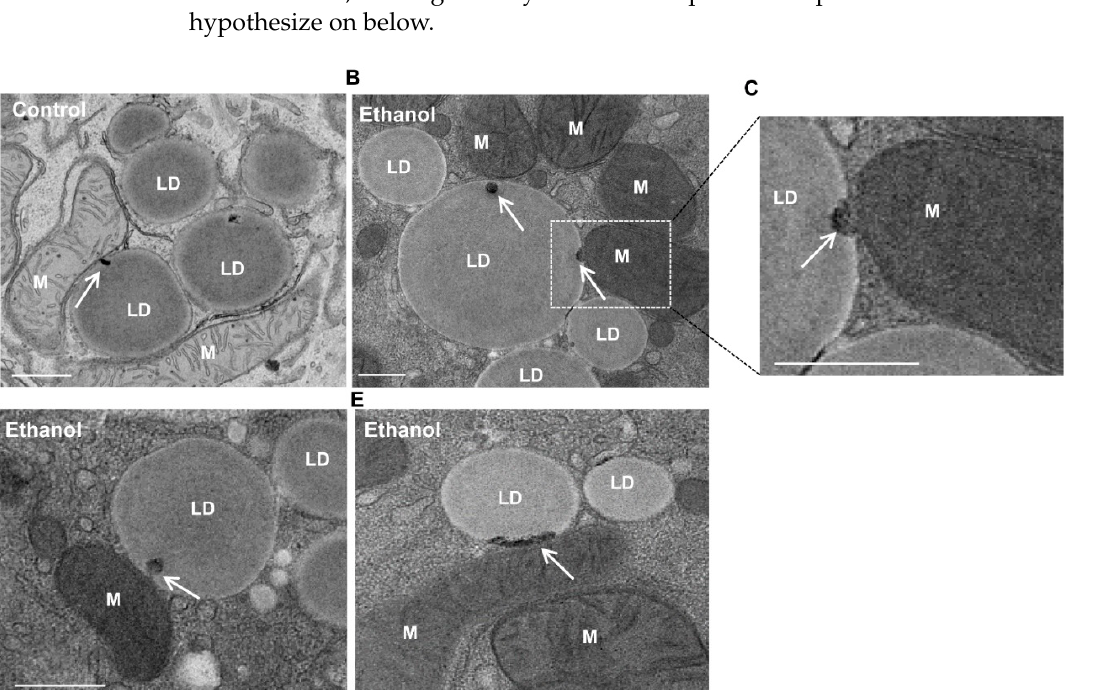
Figure 5. Dot- or tubular-like mitochondria–LD contact sites in starved or oleic-acid-treated primary mouse hepatocytes. Primary mouse hepatocytes were cultured in EBSS for 2 h followed by EM analysis. ( A ) Representative EM images from hepatocytes cultured in EBSS are shown. Hepatocytes isolated from liver-specific Atg5 knockout (KO) mice and the matched wild-type (WT) mice were treated with oleic acid (OA, 500 µM) for 6 h followed by EM analysis. ( B ) Representa- tive EM images from OA-treated WT hepatocytes and Atg5 KO hepatocytes are shown. White arrows denote electron- dense dot- and tubular-like mitochondria–LD contact sites. Red arrows denote peroxisome–LD contact. LD: lipid droplet; M: mitochondria; P: peroxisome. Bar: 500 nm.